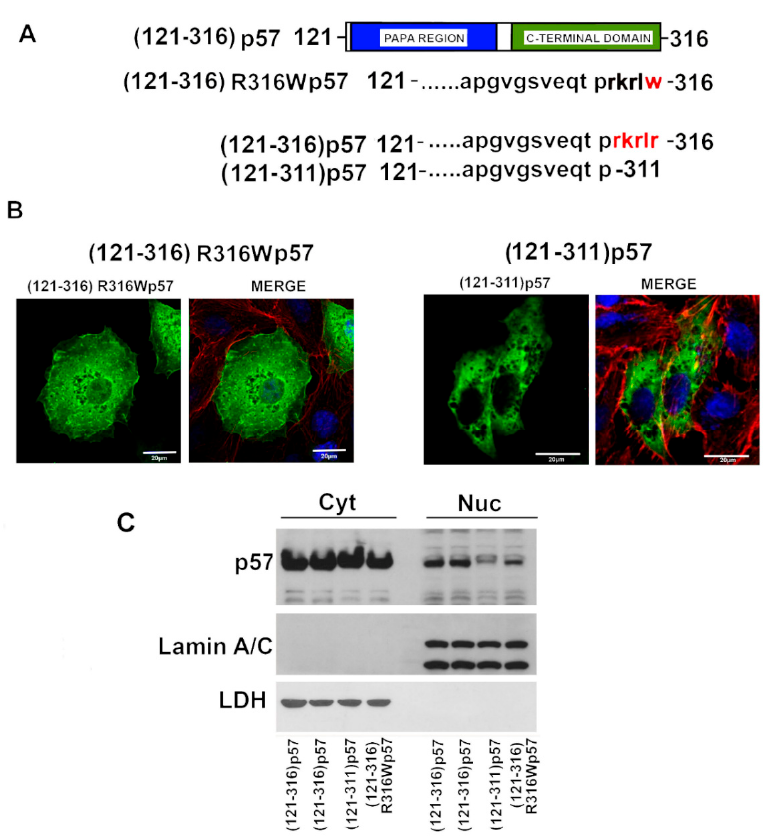
Figure 4. Cellular distribution of the (121-316)p57, (121-316)R316Wp57, and the truncated fragment (121–311)p57. ( A ) Schematic representation of the human C-term (121–316)p57 fragment, the mutagenized (121–316)R316Wp57, and the truncated (121–311)p57 protein fragments. ( B ) Representative immunofluorescence images of HepG2 cells transfected with the plasmids encoding the indicated proteins listed in panel A. p57 (green), DNA (blue), and F-ACTIN (red). Scale bar 20 µm. For further details refer to the Materials and Methods Section. ( C ) WB analysis of the cytosolic and nuclear content of p57 in HEK293 after 24h of transfection with the plasmids represented in panel A. Lamin A/C and LDH were analyzed to confirm the proper separation of nuclear and cytosolic fractions and as control for equal protein loading.